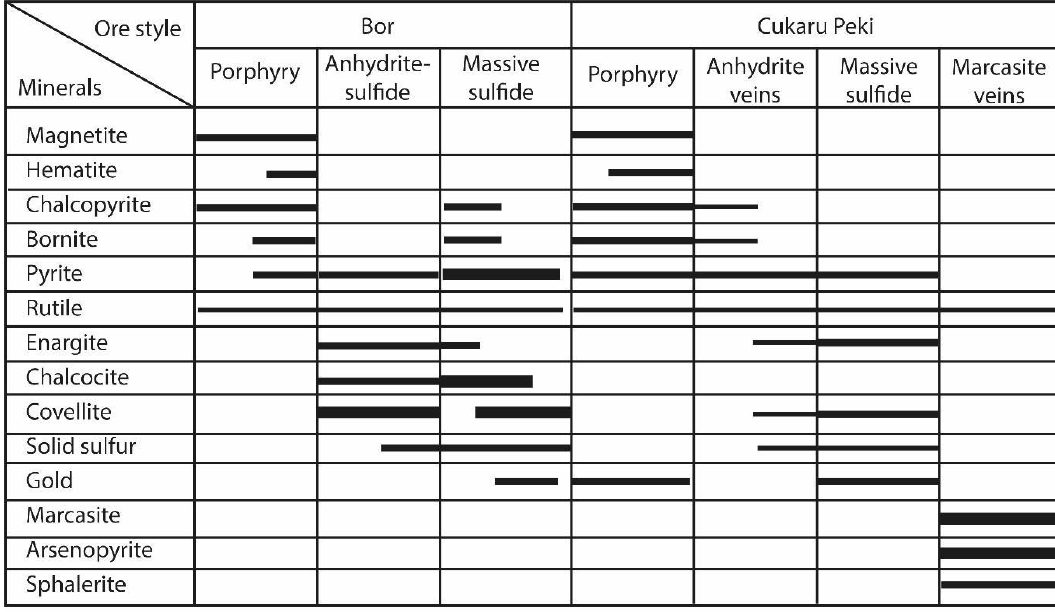
Figure 8. Comparison of paragenetic sequences between Bor and Cukaru Peki.